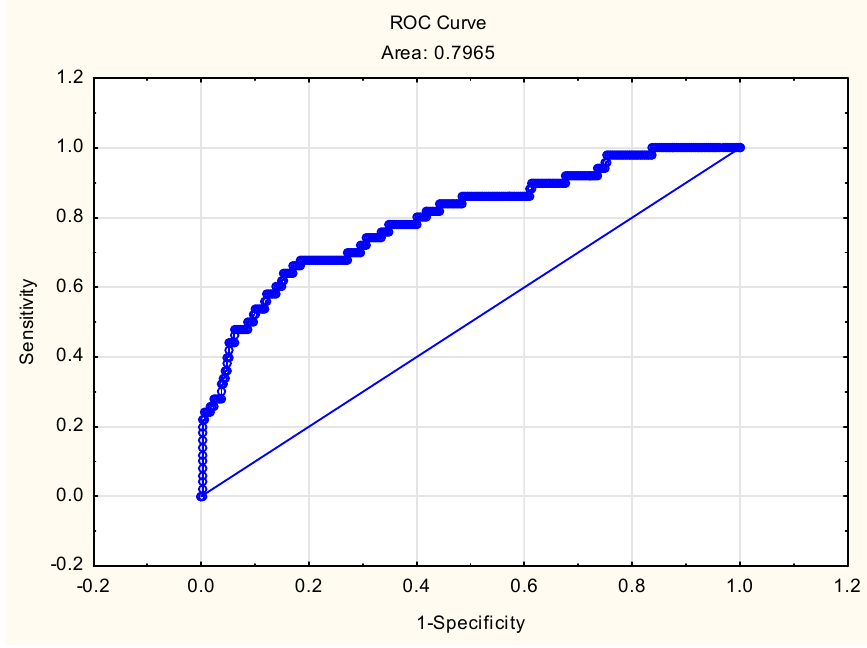
Figure 2. Receiver Operating Characteristic (ROC) curve for the Logit model.